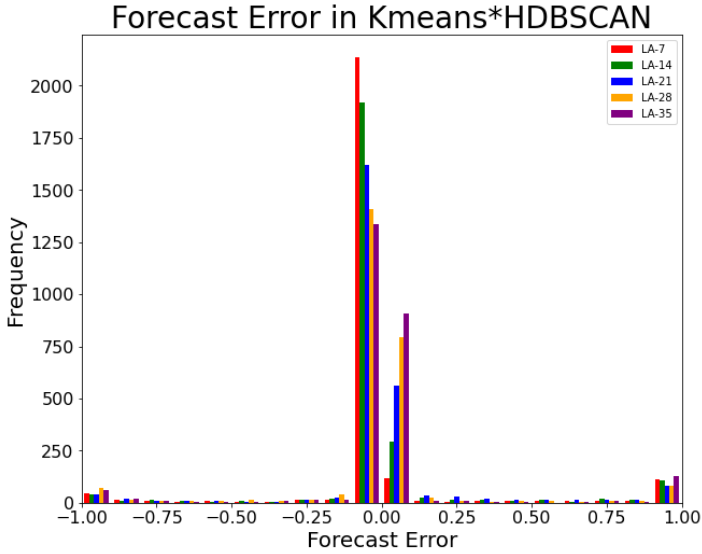
Figure 17. The Forecast Error Histogram of Kmeans*HDBSCAN in 20